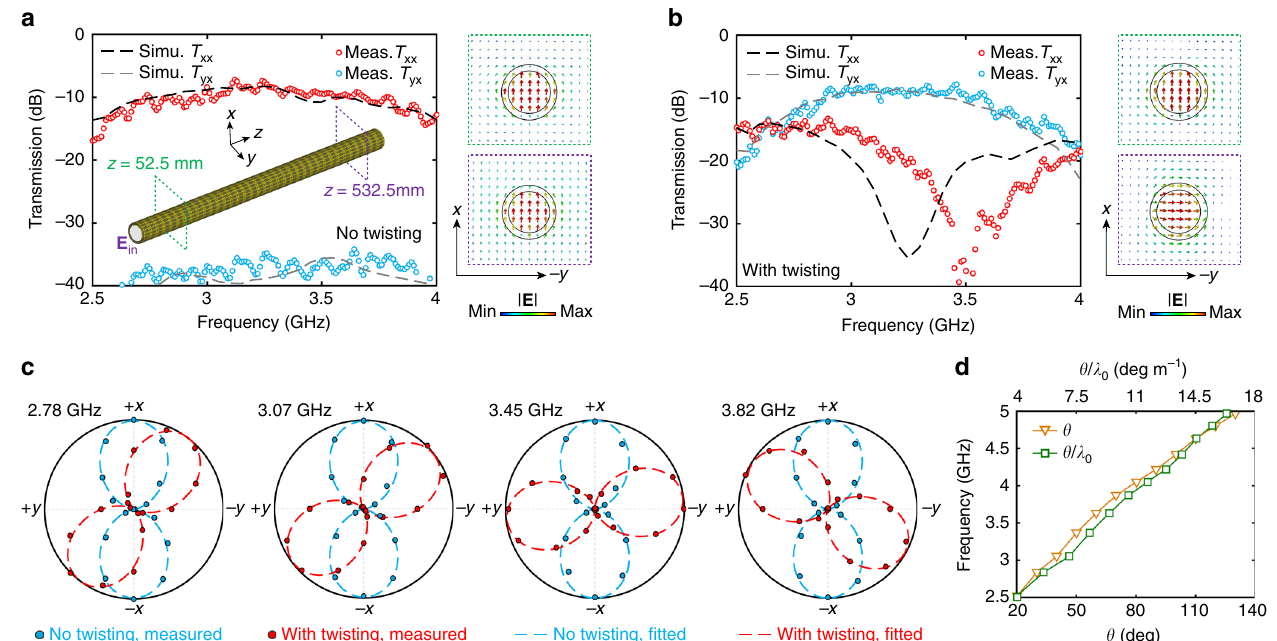
Fig. 5 A sub-wavelength dielectric rod waveguide with dual-layer metasurface coatings. Simulated and measured co-polarized ( T xx ) and cross-polarized ( T yx ) transmission between the transmitting and receiving probes for the inner coating layer a without and b with twisting perturbation. The insets show the con fi guration and the snapshots of the vector electric fi eld distribution at 3.3 GHz in the x - y planes at two different positions along the axis of the rod when excited by an x polarized probe. c Measured state-of-polarization patterns of the Te fl on rod waveguide with a dual-layer coating for the inner metasurface layer with and without twisting perturbation. d Measured rotation angle and the rotation angle per wavelength as a